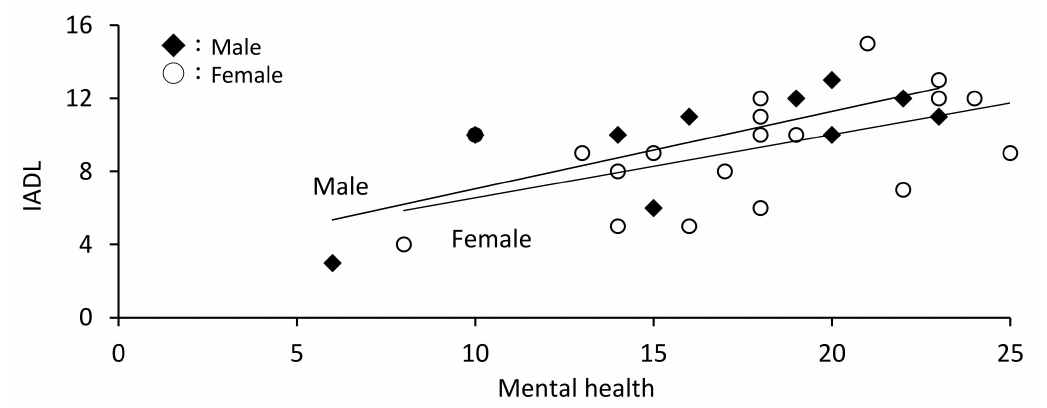
Figure 2. Association between mental health and instrumental activities of daily living (IADL) by sex.